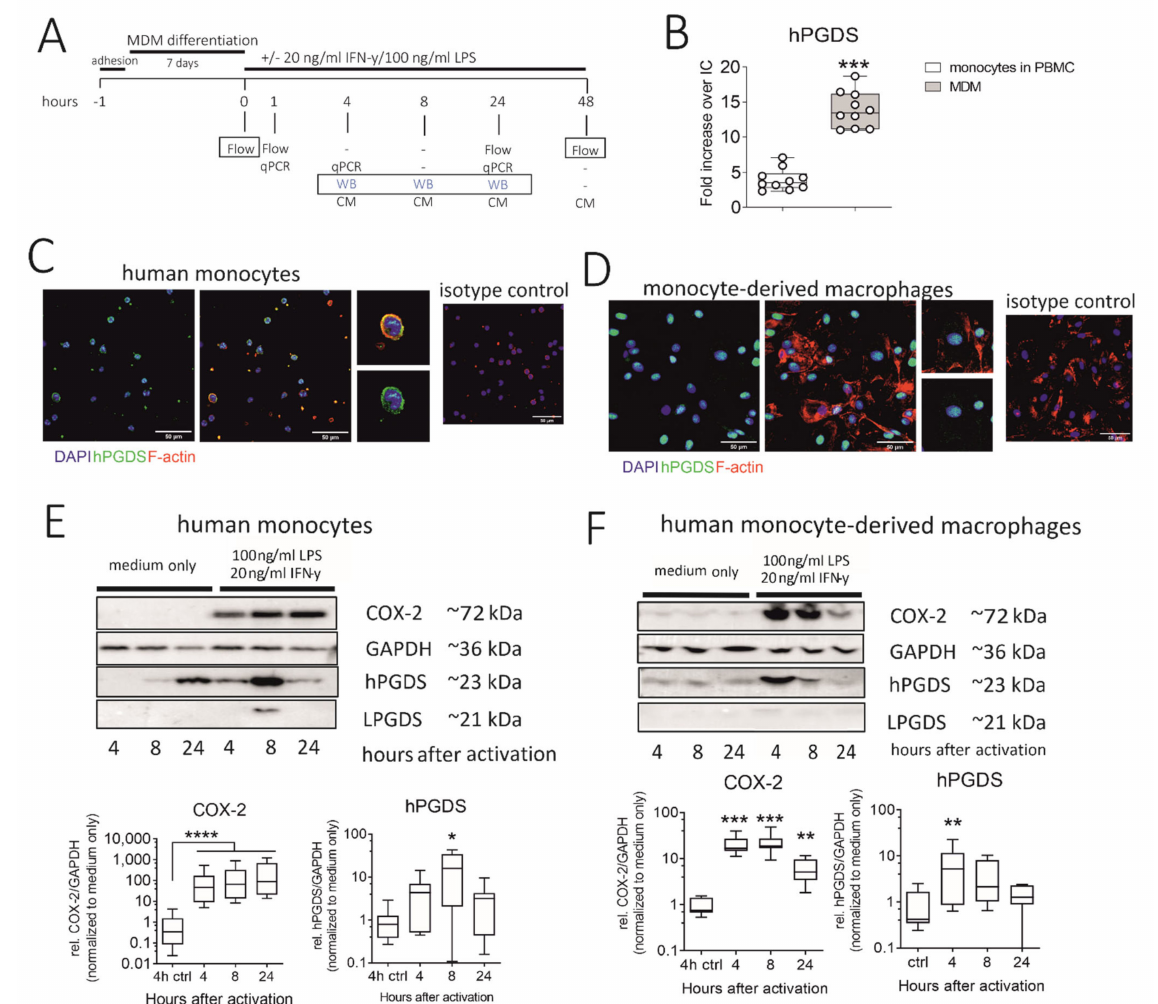
Figure 4. Human monocytes and monocyte-derived macrophages constitutively express hPGDS, which is upregulated in parallel to COX-2 by LPS/IFN- γ . ( A ) Peripheral blood monocytes were either directly activated or first differentiated into monocyte-derived macrophages (MDM). hPGDS expression was evaluated by flow cytometry, microscopy or Western blotting at indicated time points. ( B ) As evaluated by flow cytometry, MDM express higher levels of hPGDS compared to monocytes in PBMC ( n = 10). ( C ) Peripheral blood monocytes and ( D ) MDM express high basal hPGDS levels as determined by fluorescence microscopy ( n = 3 donors, scale bar 50 µ m). COX-2 and hPGDS densitometric results obtained from ( E ) monocyte and (F) macrophage lysates by Western blotting were normalized to GAPDH values and subsequently to unstimulated controls ( n = 7–8). Two-way ANOVA for repeated measurements with Dunnetts’s post hoc test (log- transformed), * p < 0.05, ** p < 0.01, *** p < 0.001, **** p <